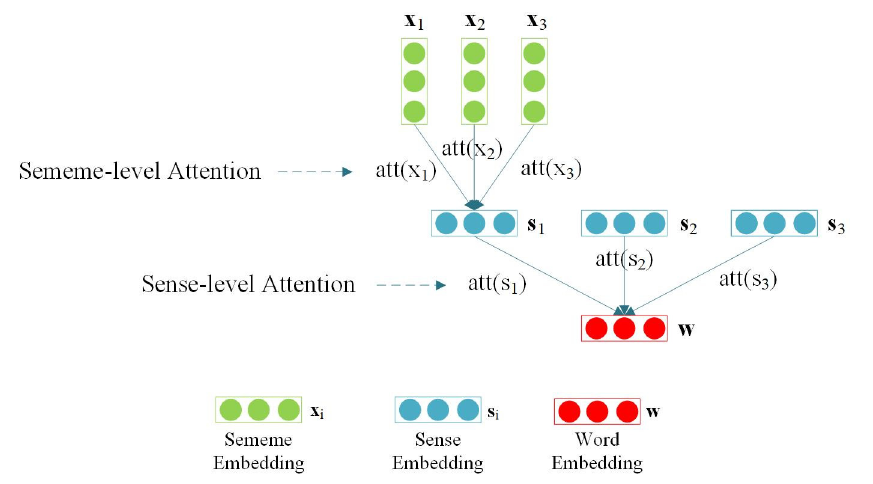
Figure 5. DAWE model.